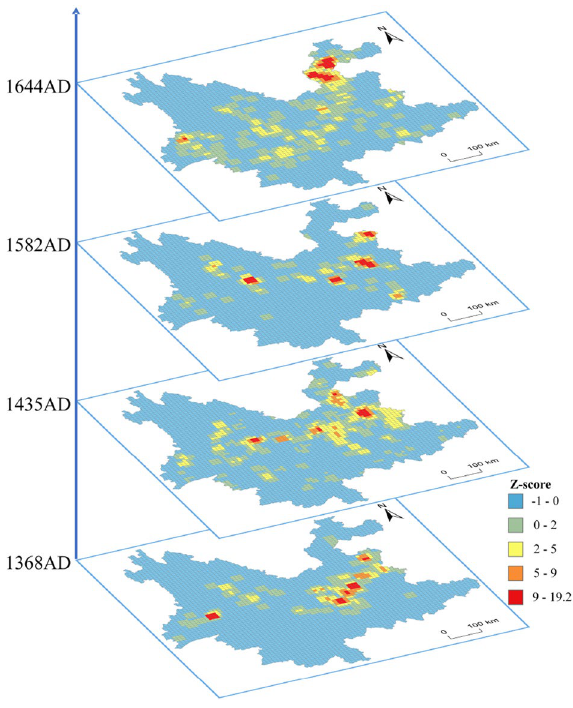
Figure 4. Emerging hot spot analysis z-score. Maps were created in ArcGIS Pro v.2.7: https:// www. esri. com (Esri, California, USA). The final layout was created in CorelDraw v. 20.1.0.707 (2018 Corel Corp.).